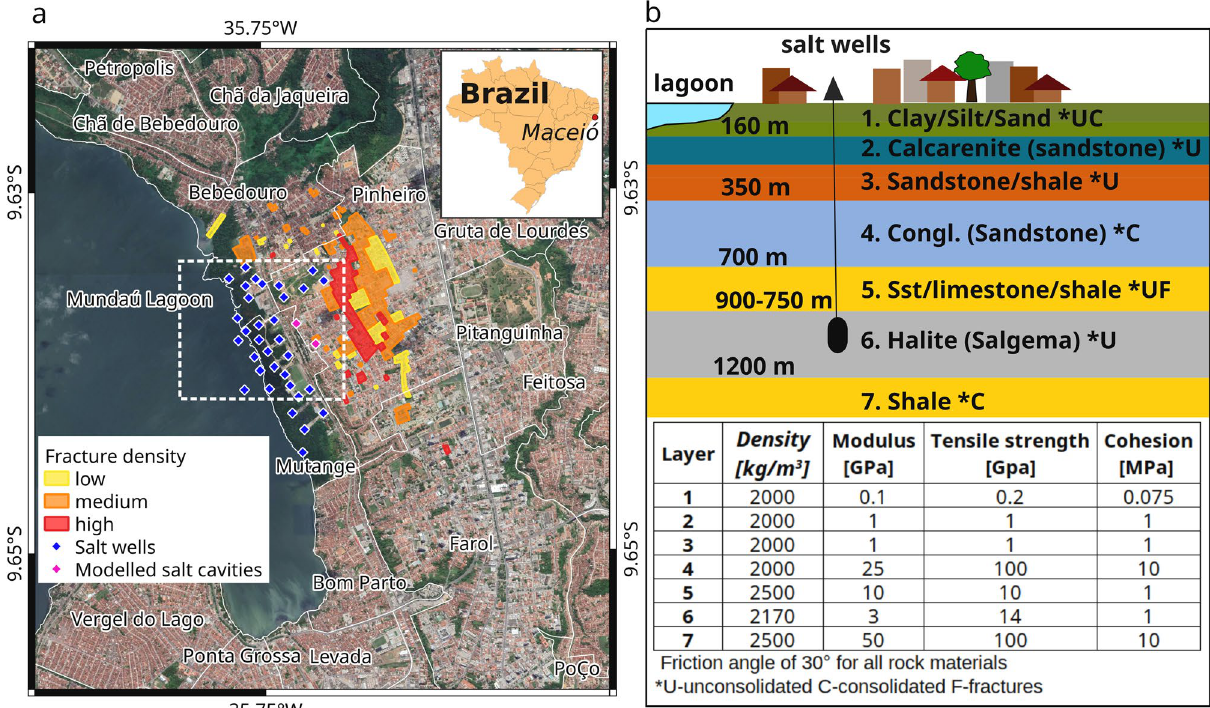
Figure 1. ( a ) Overview of the study area. Yellow, orange, and red polygons represent respectively areas with low, medium and high concentrations of fractures in buildings and infrastructures (assessment conducted by CPRM in 2018 25 ). Blue and magenta diamonds show the locations of all installed salt wells since 1970. Specifically, magenta diamonds highlight the two cavities used in the distinct element method. The white dashed polygon is the area in Fig. 3a. Inset shows the geographical location of Maceió. ( b ) Simplified geological